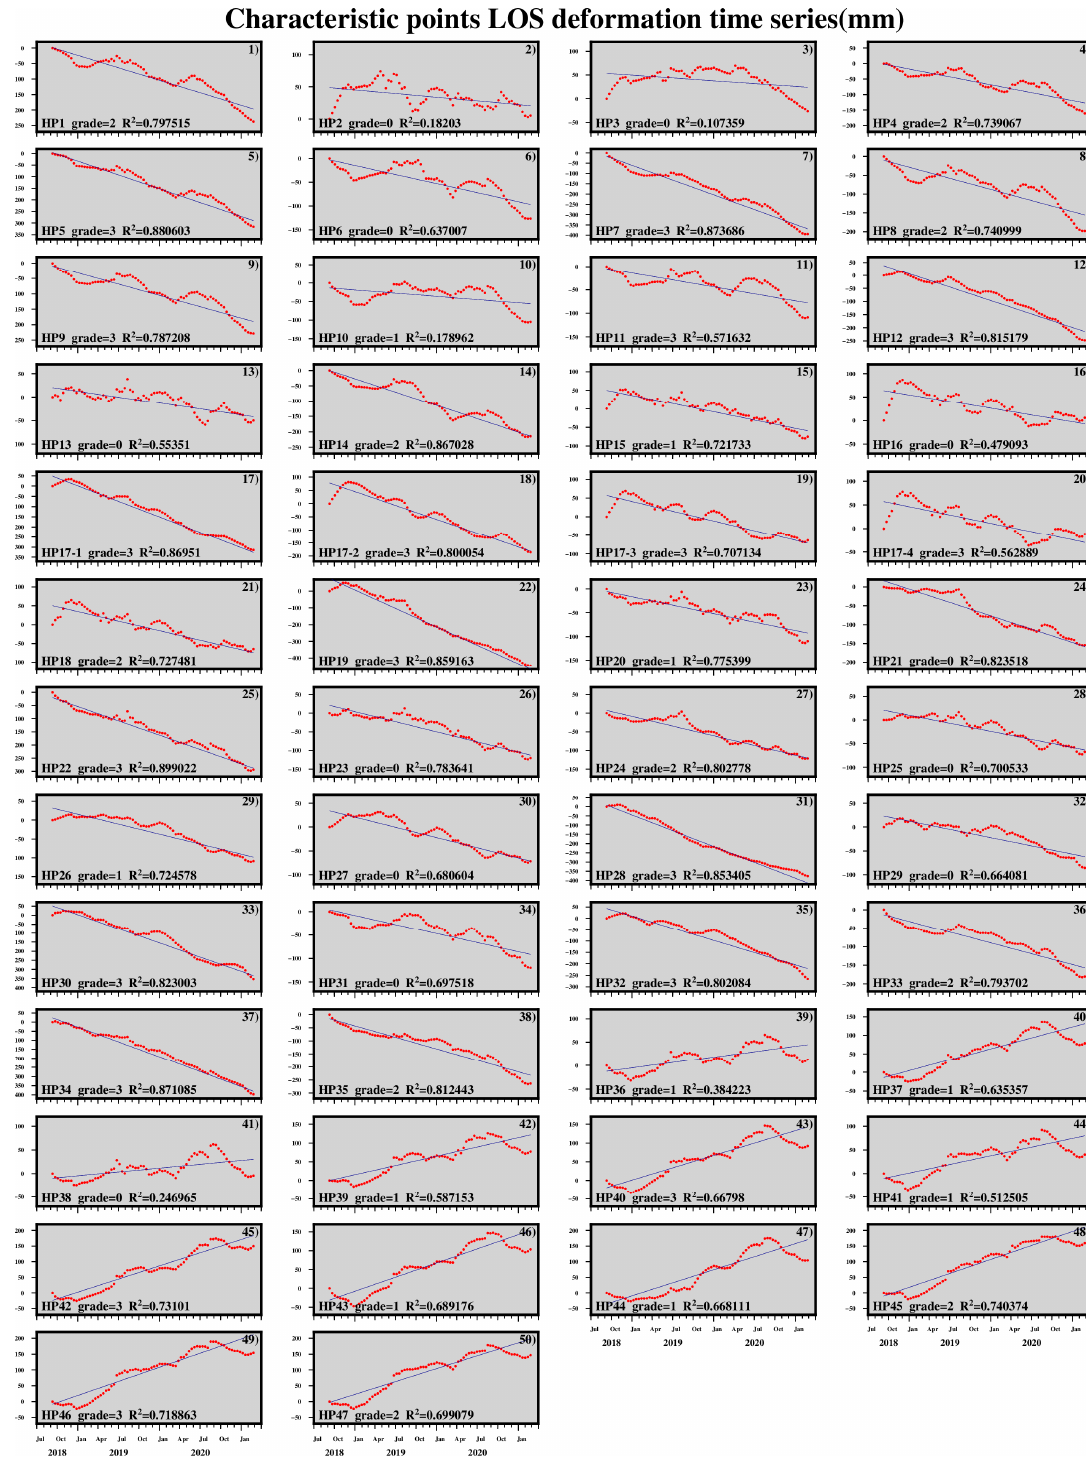
Figure 17. Time-series deformation of each landslide characteristic point. The blue solid line is the fitted linear deformation velocity, and red dots represent time-series displacement. The name, grade, and linear fitting correlation coefficient of landslides are marked in each subgraph. Subfigures (1)–(50) correspond to the numbers of the characteristic points in Figure 18 respectively.